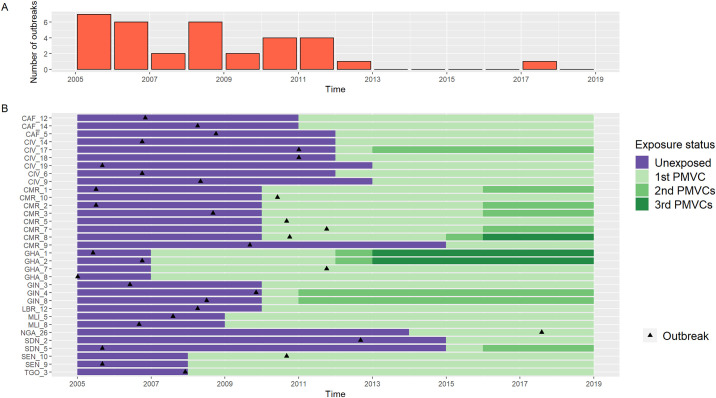
Swimmer plot of the chronology of exposure to preventive mass vaccination campaigns (PMVCs) and yellow fever outbreaks among the 33 African provinces both affected by an outbreak and targeted for a PMVC (2005–2018).(A) Time distribution of yellow fever outbreaks. (B) Swimmer plot. The 3-letter codes on the y-axis refer to International Organization for Standardization county codes (see S2 Table for complete province and country names).